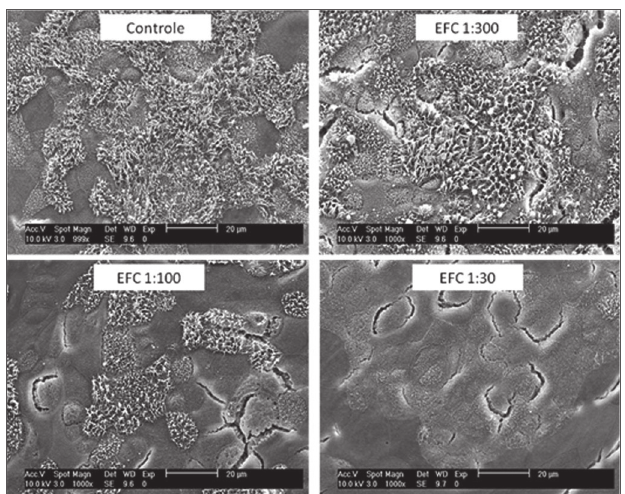
Figura 1. Fotografias de microscopia eletrônica de varredura de- monstrando efeito dose-dependente da fumaça de cigarro sobre a porcentagem de área ciliada após exposição a diluições decrescentes de Extrato de Fumaça de Cigarro (EFC).